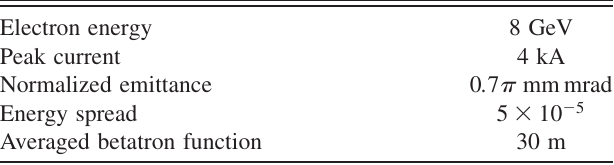
TABLE I. Electron-beam parameters for the gain length cal- culation.